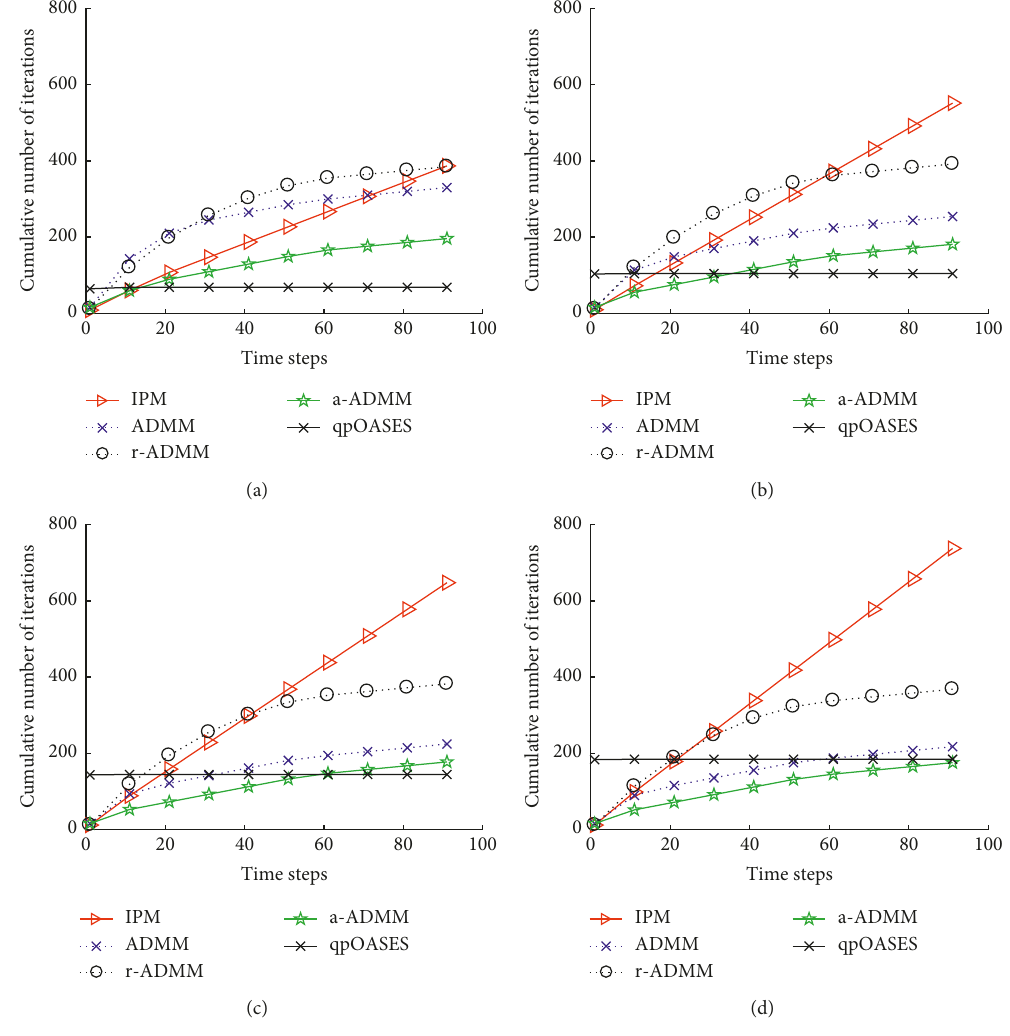
Figure 5: Convergence performance (cumulative number of iterations on y -axis) versus number of time steps (time steps on x -axis) of IPM, qpOASES, ADMM, r-ADMM, and a-ADMM on UAV control task with N ranging from 10 to 40: (a) N � 10, (b) N � 20, (c) N � 30, and (d) N �